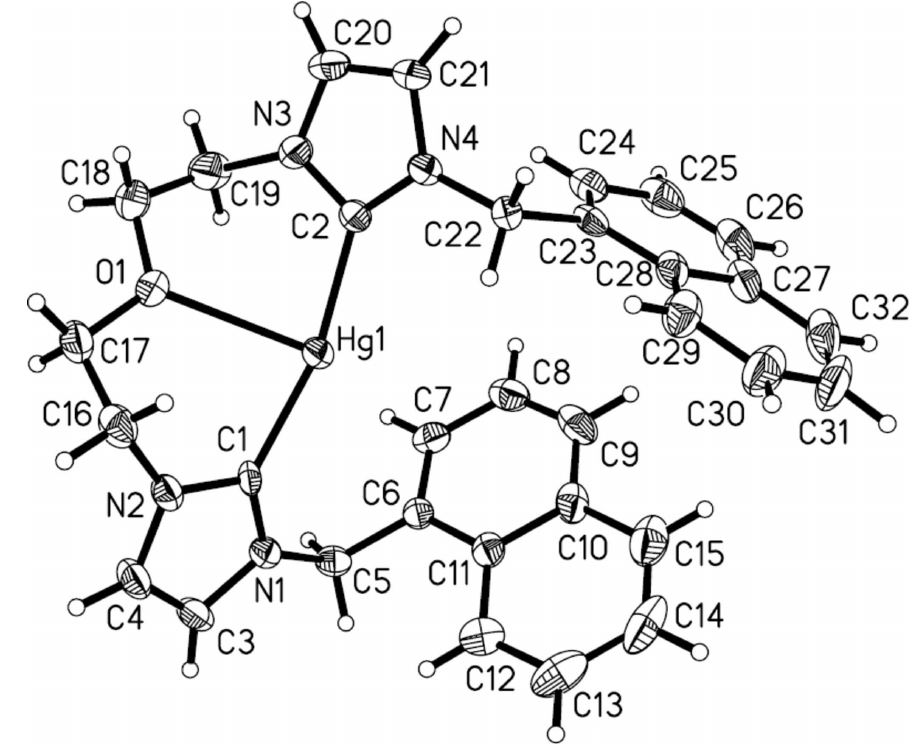
Figure 1 The molecular structure of the cation in (I) showing the atomic numbering and 30% probability displacement ellipsoids. [3,3 ′ -Bis(1-naphthylmethyl)-1,1 ′ -(2,2 ′ -oxydiethylene)bis(imidazol-2- ylidene)]mercury(II) bis(hexafluoridophosphate) acetonitrile solvate Crystal